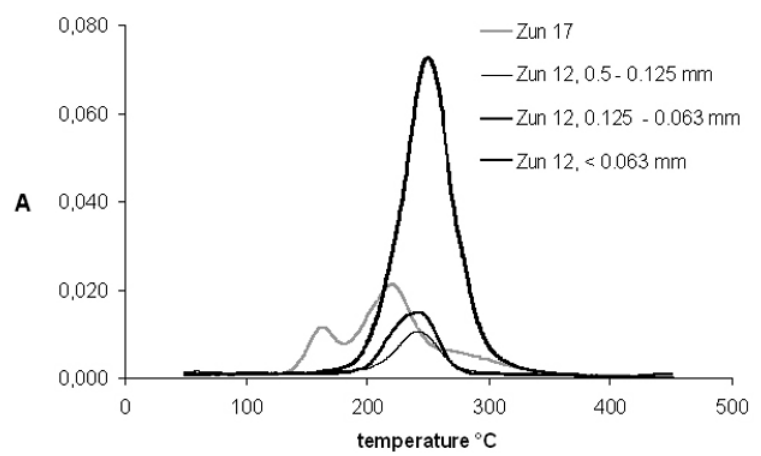
Figure 5. Mercury release curves of real